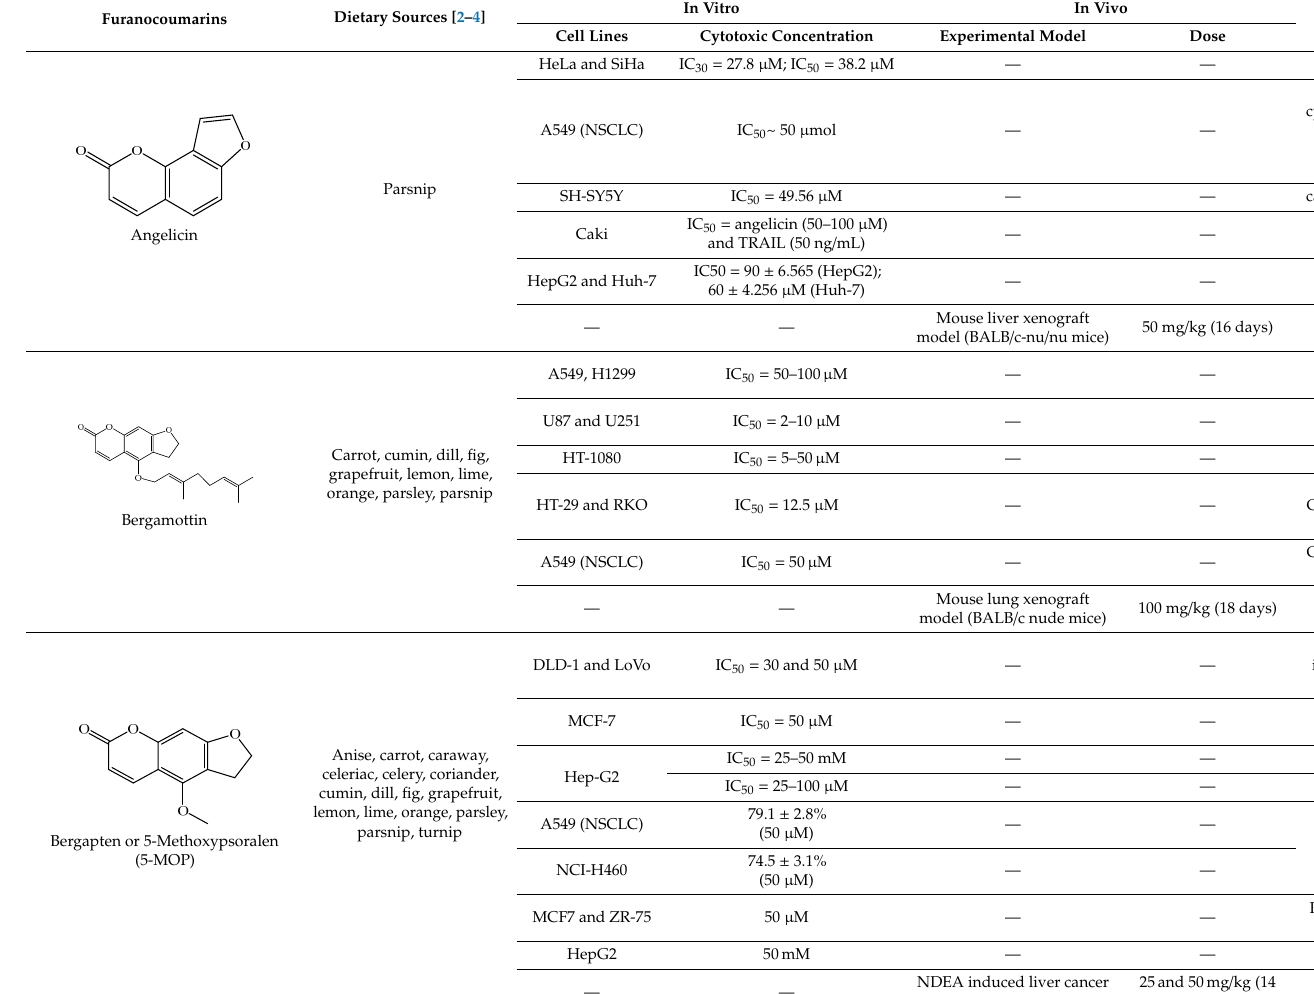
Table 1. Anticancer effects of furanocoumarins in the different reported studies. Furanocoumarins Dietary Sources